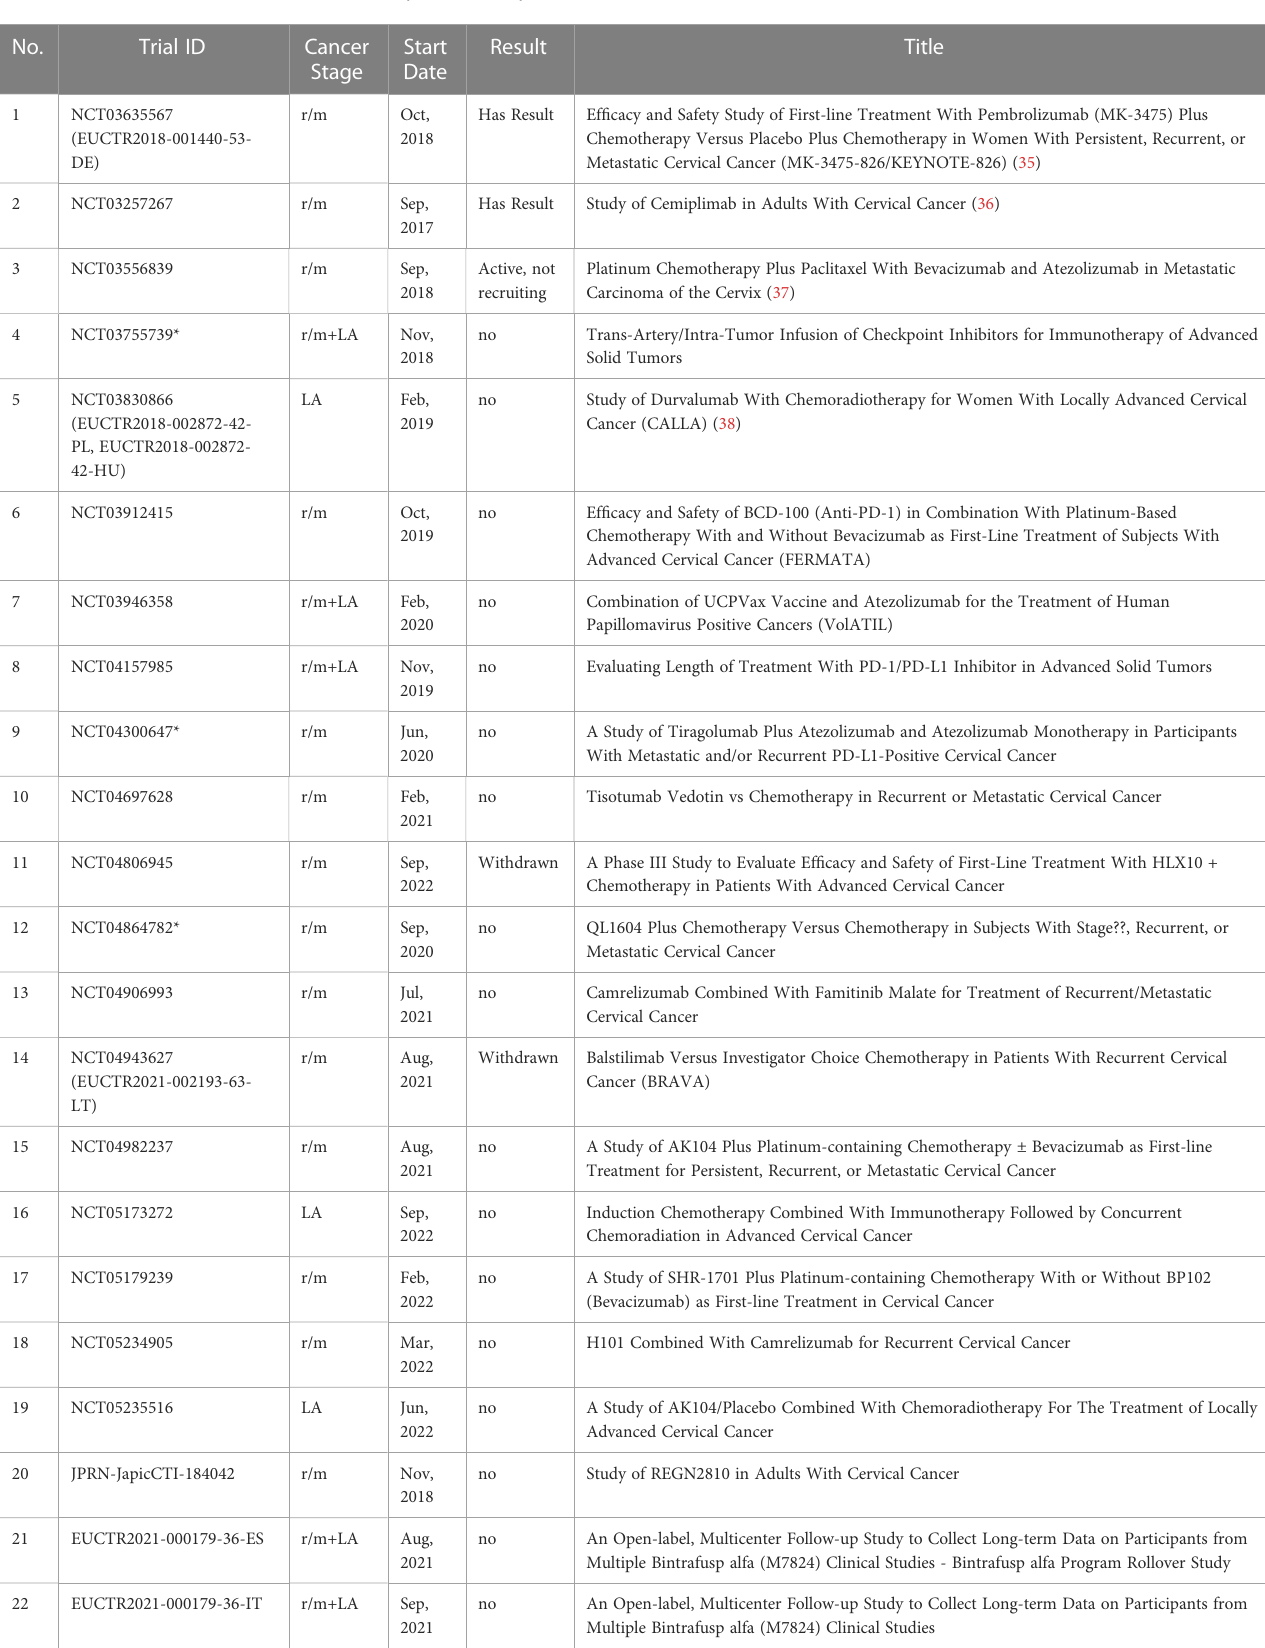
r/m means recurrent or metastatic, and LA means locally advanced. * means clinical trials are Phase II|Phase